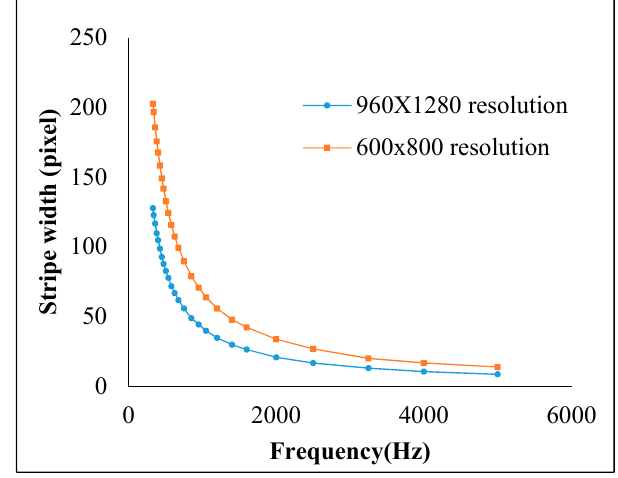
Figure 25. Roll width feature with respect to signal frequency and image sensor resolution.